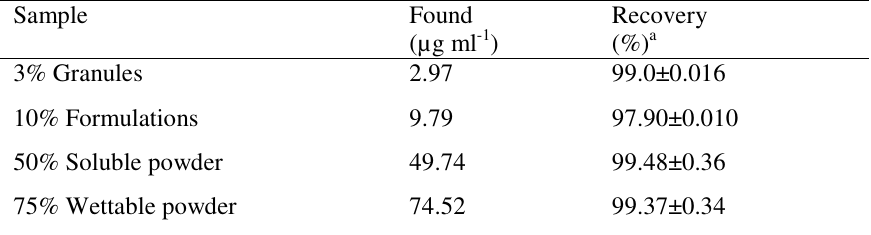
Table 1 Determination of carbofuran in insecticidal